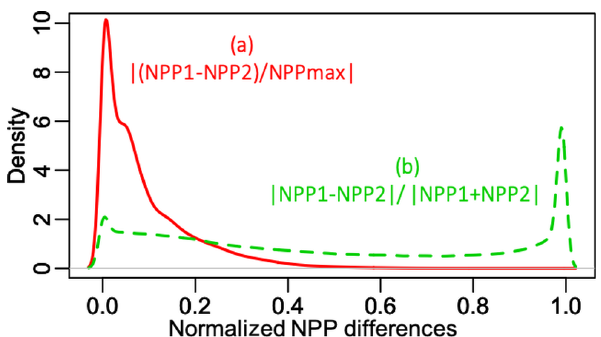
Figure 7. Histograms of (a) the absolute values of the six NPP dif- ferences normalized by NPP max and (b) the normalized relative dif-